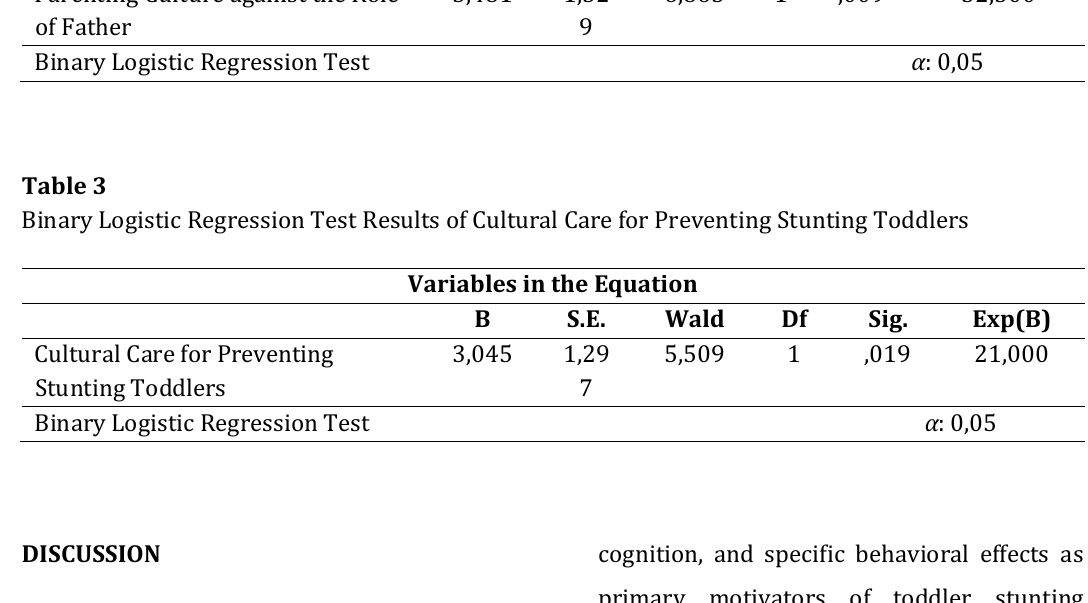
Table 2 Results of Binary Logistic Regression of parenting culture against the role of father Parenting Culture against the Role of Father Binary Logistic Regression Test